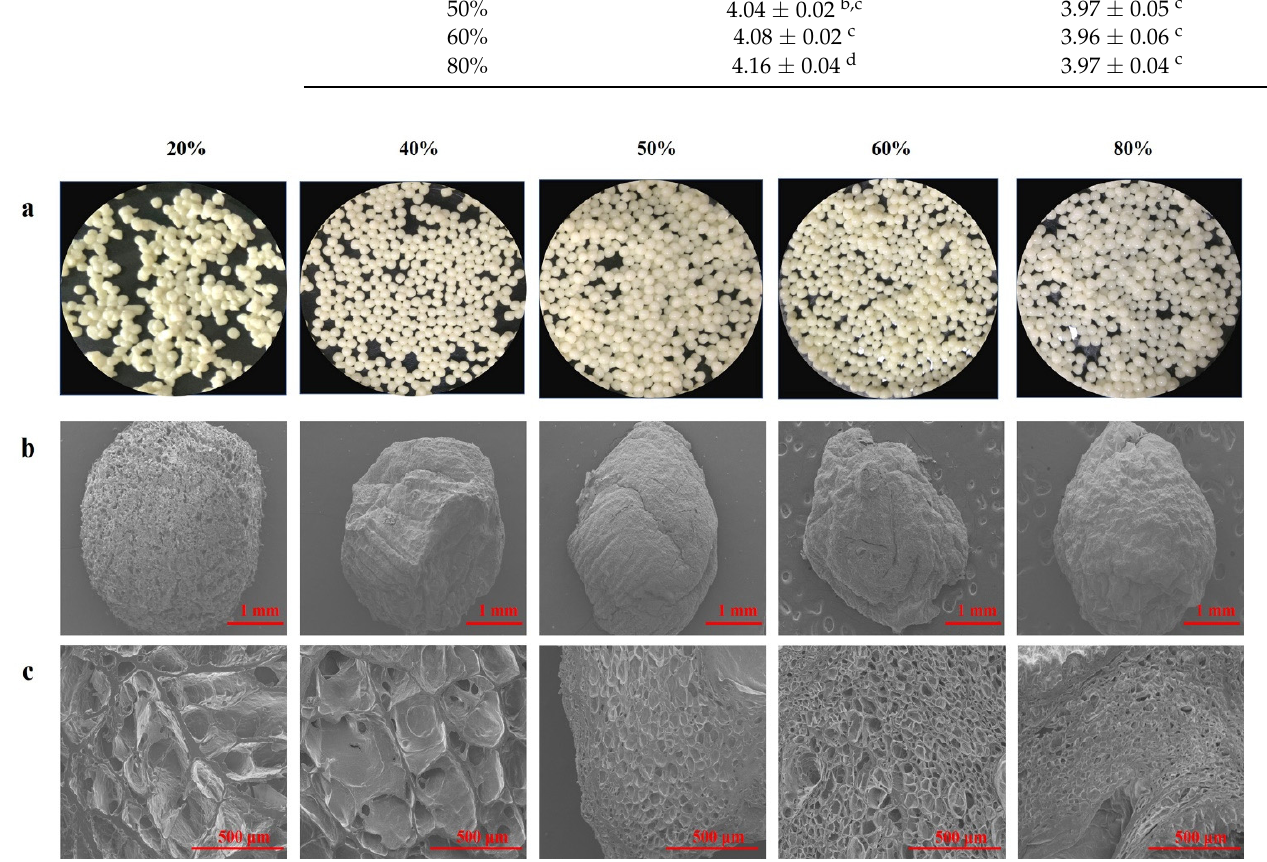
Figure 5. Images of quercetin-loaded beads with different content of pectin: ( a ) Fresh morphology of emulsion gel beads; The SEM pictures were taken at 30× ( b ) and ( c ) 100×. emulsion gel beads; The SEM pictures were taken at 30 × ( b ) and ( c ) 100 ×